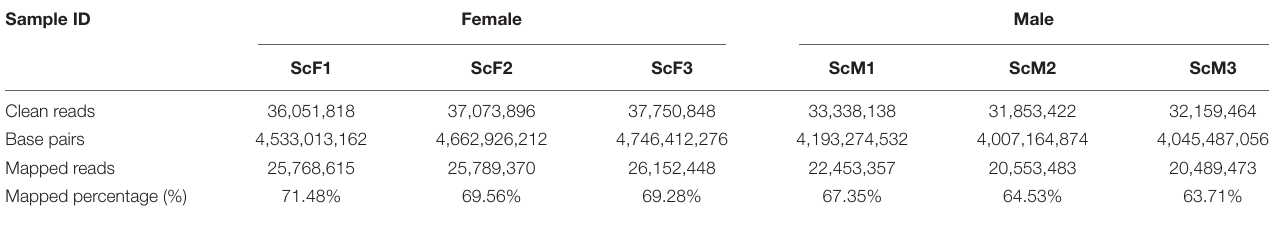
TABLE 2 | Summary statistics of gonad transcriptome sequencing for S. constricta from ovary and testis. Sample